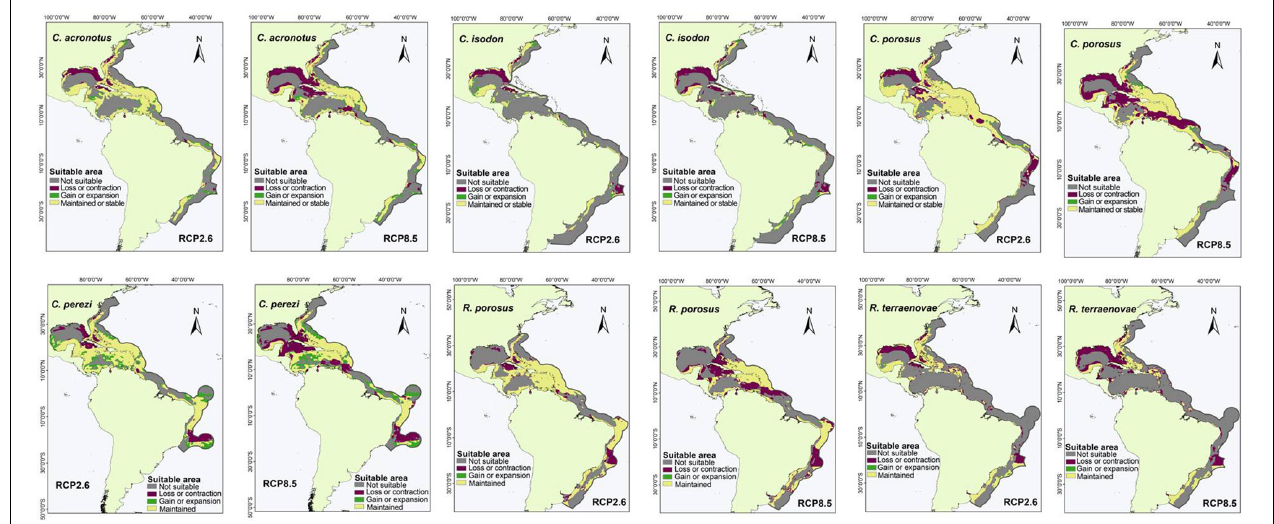
FIGURE 2 | Suitable areas maintained, gained, and lost by the year 2050 under low (RCP2.6) and high (RCP8.5) greenhouse gas emission scenarios in species with an M area in the western Atlantic Ocean: Carcharhinus acronotus, Carcharhinus isodon, Carcharhinus porosus, Carcharhinus perezi, Rhizoprionodon porosus, and Rhizoprionodon terraenovae